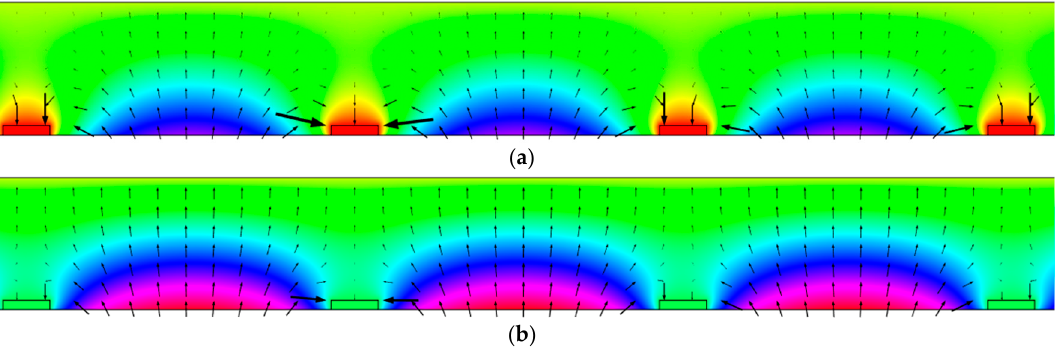
Figure 2. The electrical field distribution passing through intermediate electrode perforations: ( a ) Intermediate electrode voltage V i = − 0.2 V pull-in ; ( b ) Intermediate electrode voltage V i = 0.2 V pull-in